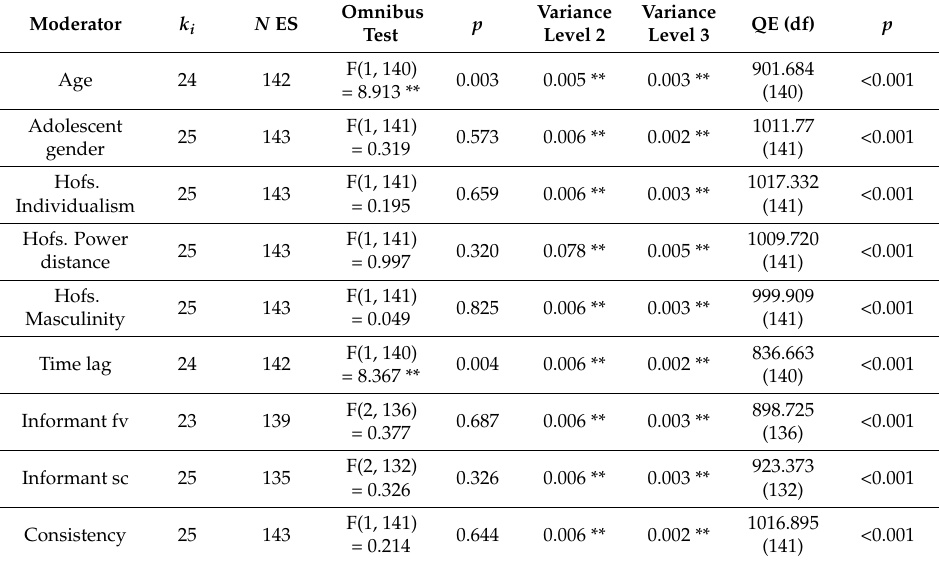
Table 2. Assessing moderators: The QE statistics illustrating residual heterogeneity, and the Omnibus to test the effect of the moderators on the family violence-self-control association.